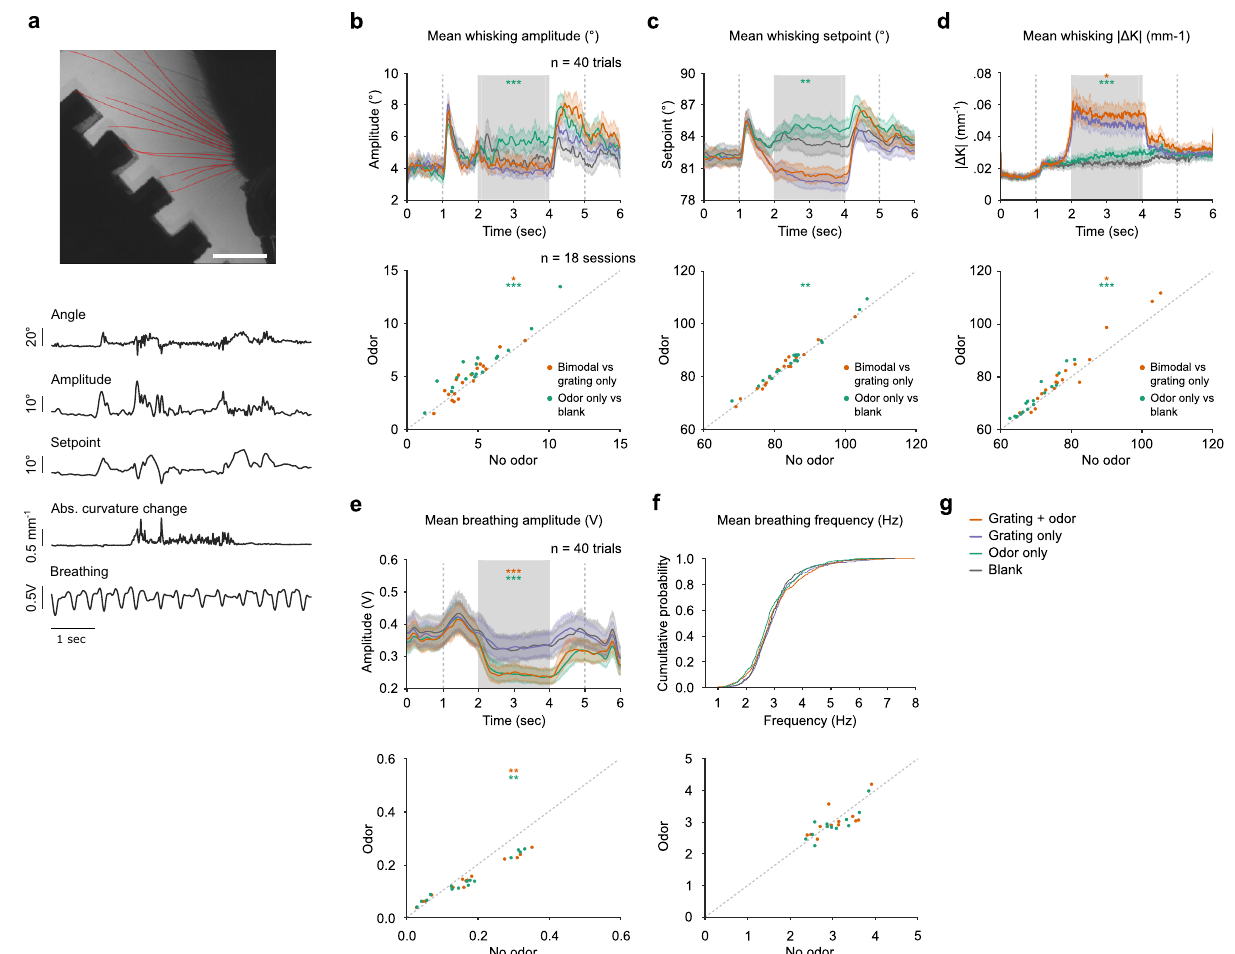
Fig. 3 Olfactory stimulations decrease breathing and increase whisking kinematics. a Example frame of whisker tracking with traces of derived whisking kinematic parameters and breathing shown below (scale bar: 7 mm). b Top: mean whisking amplitude across time within sessions. Bottom: scatter plot of mean whisking amplitude between sessions at stimulus presentation. Whisking was analyzed over the 2-s stimulation epoch indicated by gray shading (orange: bimodal versus grating only; green: odor alone versus blank). c Top: mean setpoint within sessions. Bottom: mean setpoint between sessions. d Mean absolute curvature change within sessions. Bottom: mean absolute curvature change between sessions. e Mean breathing amplitude within sessions. Bottom: mean breathing amplitude between sessions. f Cumulative distribution of breathing frequency within sessions. Bottom: mean breathing frequency between sessions. n = 18 sessions from 10 mice; * P < 0.05, ** P < 0.01, *** P < 0.001; Wilcoxon signed-rank test; see Supplementary Tables 1 and 2 for detailed statistics. g Legend to ( b – f ) top. Error bands indicate 95% con fi dence intervals for the mean throughout the fi gure. All tests are